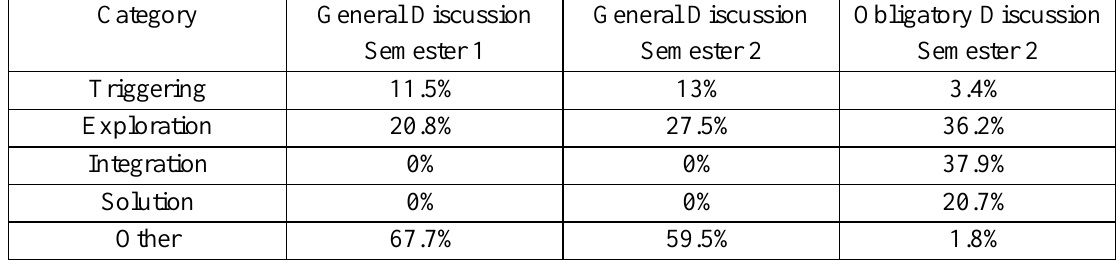
Categorizing of